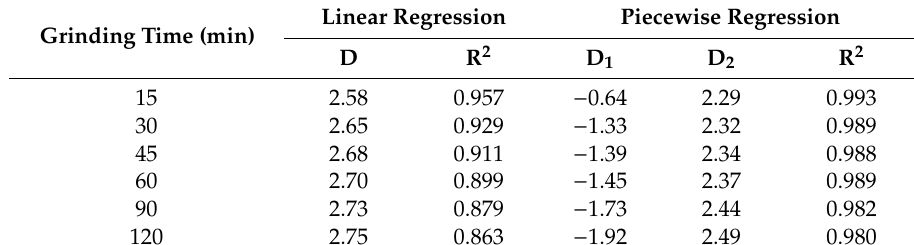
Table 6. Fractal dimensions calculated with the use of simple linear model and piecewise linear regression. Linear Regression Piecewise Regression Grinding Time (min)